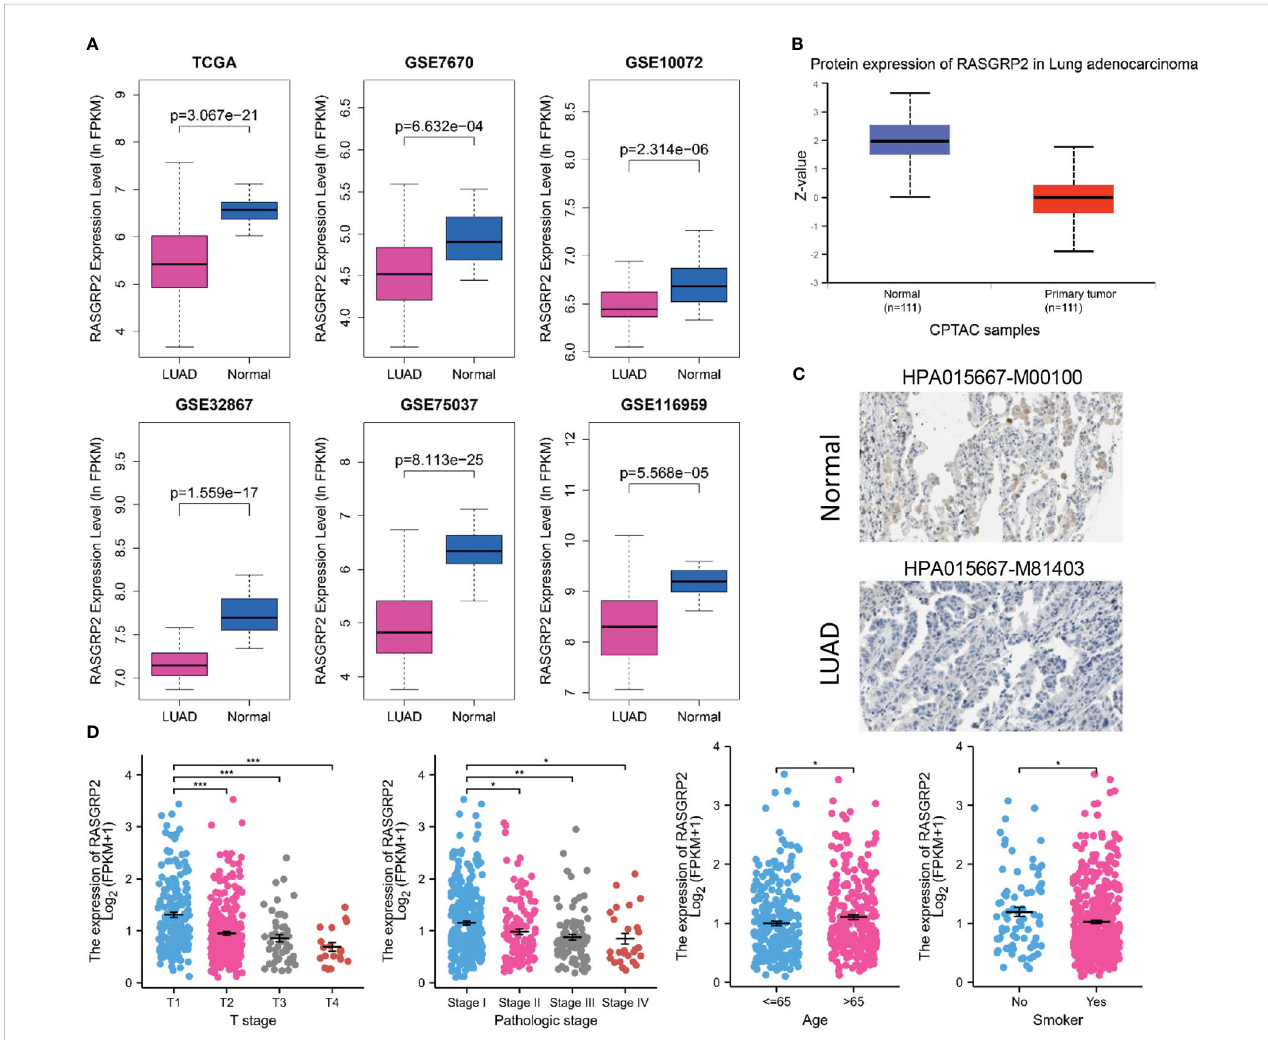
FIGURE 2 RASGRP2 expression was signi fi cantly lower and was associated with malignant clinicopathological parameters in LUAD. (A) Data from six different datasets showed that compared with non-tumor tissues, RASGRP2 mRNA was down-regulated in tumor tissues (P < 0.05). (B) Protein expression of RASGRP2 in LUAD was lower than that in normal tissues (P < 0.05) according to CPTAC samples. (C) Immunohistochemistry demonstrated the lower expression of RASGRP2 in LUAD. (D) The expression of RASGRP2 correlated with T stage, pathologic stage, age and smoke. ***P < 0.001, **P < 0.01, *P <